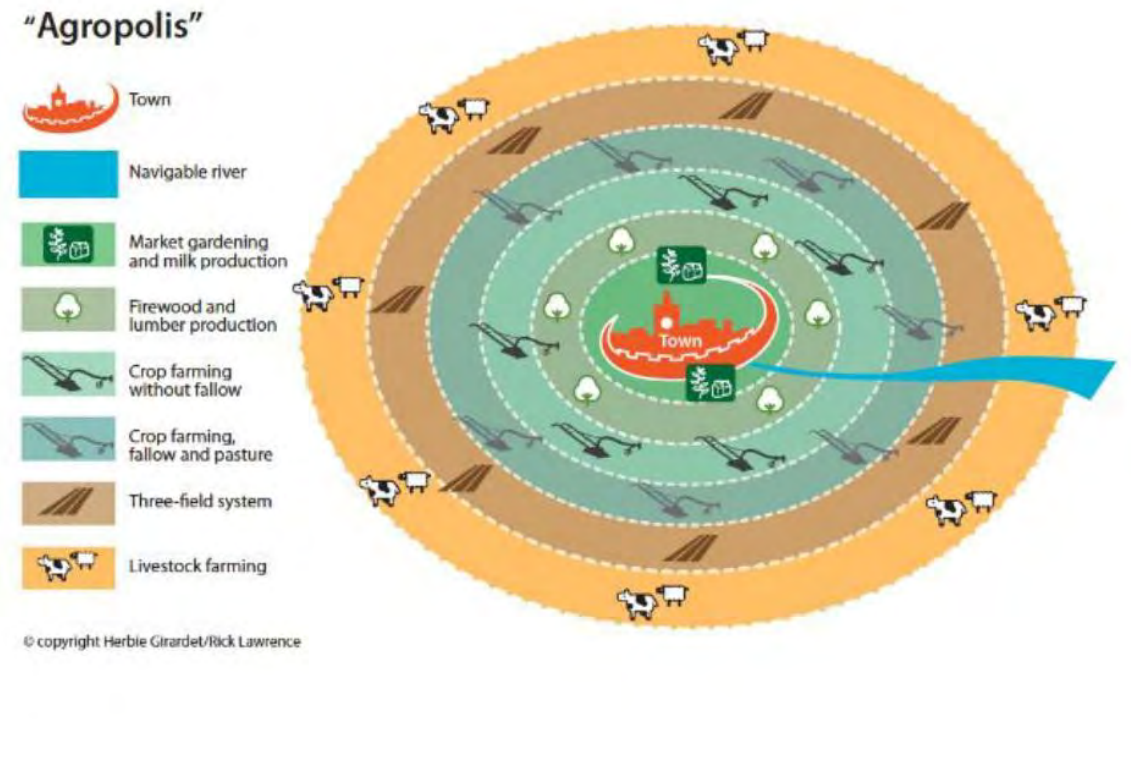
Figure 6. A diagram representing the agropolis (Girardet, 2015).